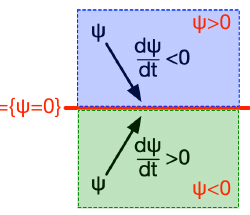
Figure 4. Reachability